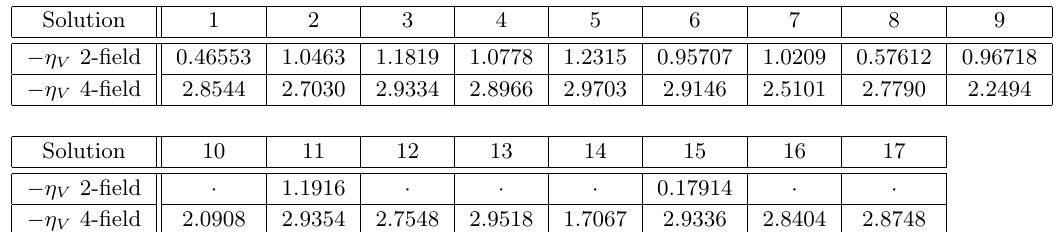
Figure 1. Potential 2 V ( (cid:26); (cid:28); (cid:27) 1 ; (cid:27) 2 ) around its de Sitter extremum corresponding to solution M 2 p 16. The potential is displayed along a (cid:13)uctuation s around (cid:27) 1 = 1, and another one t along the tachyonic direction (1 ; 1 ; 1 ; 1) + t~v , where ~v is the eigenvector associated to the negative eigenvalue of the mass matrix, at the extremum. At s = t = 0, we verify the positive maximum along one direction, and minimum along the other one.